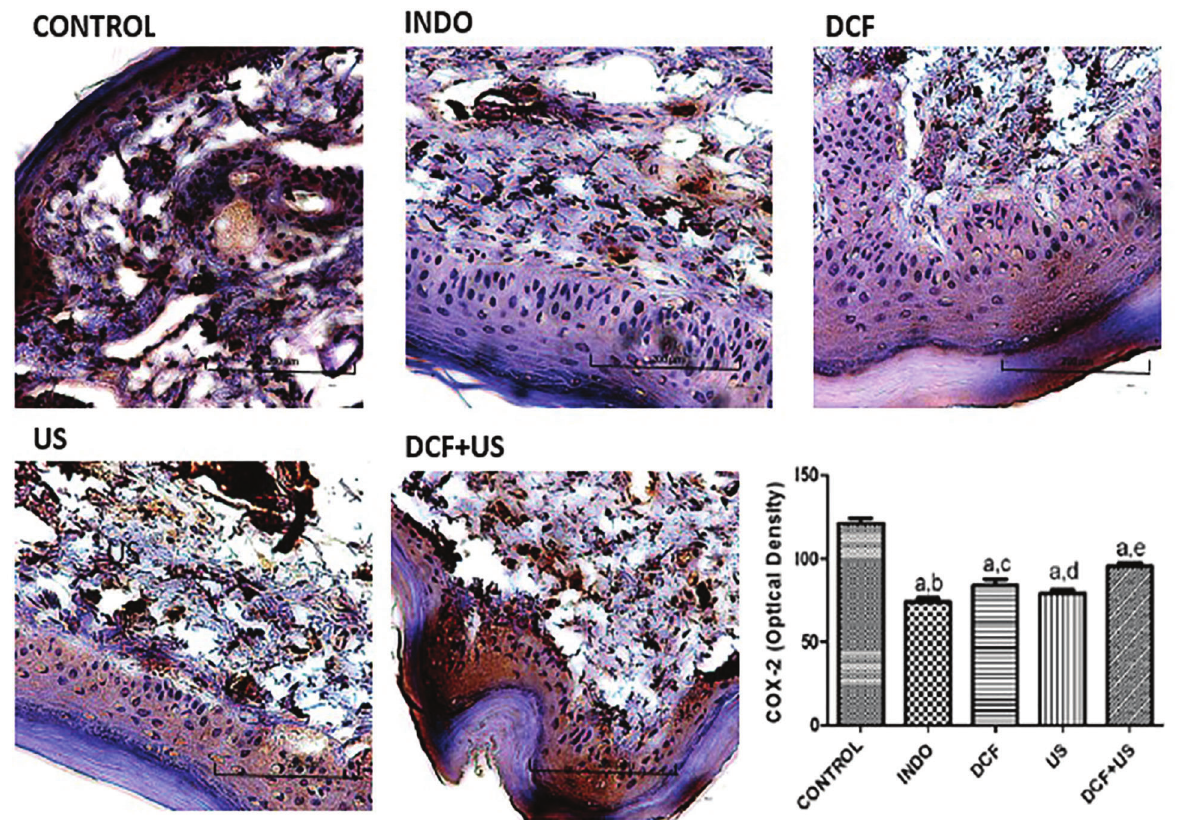
Figure 5. Representative photomicrographs of immunohistochemistry for cyclooxygenase-2 (COX-2) (400 (cid:1) , bar=200 m m) of tissues from the right paw of rats submitted to the carrageenan-induced paw edema model. The Control (untreated) group was compared with the groups treated with 20 mg/kg indomethacin, po (INDO), 10 mg/g diclofenac (DCF), ultrasound (US, 1 w/cm 2 , 1 min), and ultrasound associated with diclofenac (DCF + US). The graph shows the data analyzed by the ImageJ program. Data are reported as mean ± SE. a P o 0.001 vs CONTROL; b P o 0.05 vs DCF; c P o 0.01, d P o 0.01 vs DCF + US. e P o 0.001 vs INDO. (one-way ANOVA and Newman- Keuls with post hoc